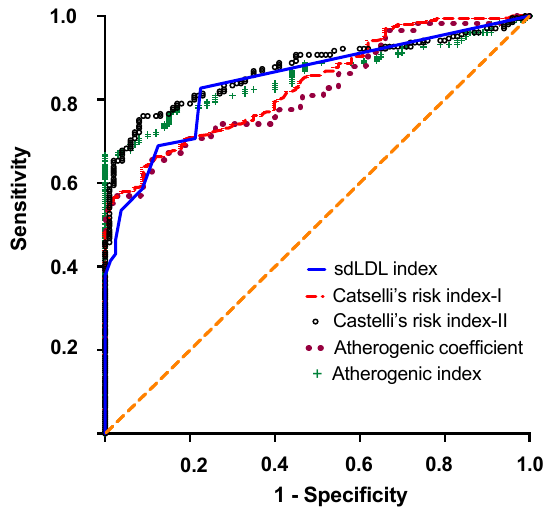
Figure 4. Receiver operating characteristic (ROC) curves showing the discriminatory power of sdLDL, AIP, AC, CR-I, and CRII.